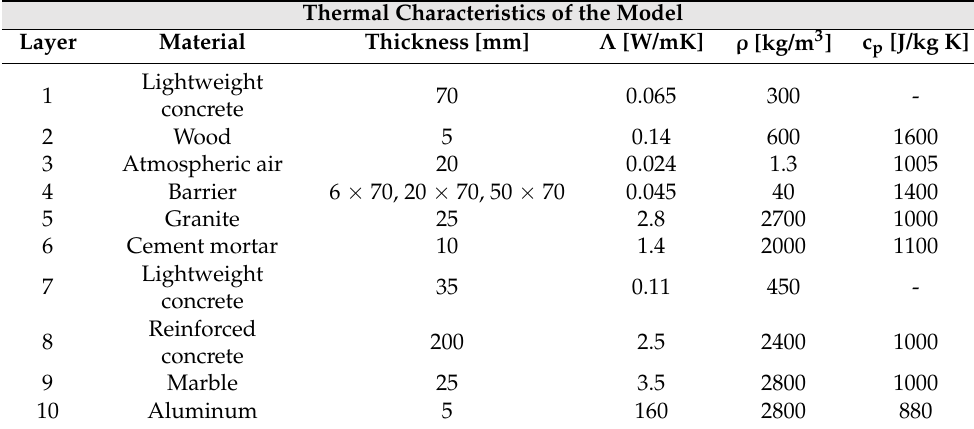
Figure 9. ( a ) No thermal break, heat transfer analysis w/m 2 ; ( b ) no thermal break, temperature analysis ◦ C; ( c ) aluminum, T. break 6 mm, H/T analysis w/m 2 ; ( d ) aluminum, T. break 6 mm, temperatures ◦ C; ( e ) aluminum, T. break 20 mm, H/T analysis w/m 2 ; ( f ) aluminum, T. break 20 mm, temperatures ◦ C; ( g ) aluminum, T. break 50 mm, H/T analysis w/m 2 ; ( h ) aluminum, T. break 50 mm, temperatures ◦ C. Table 1. Thermal characteristics of the